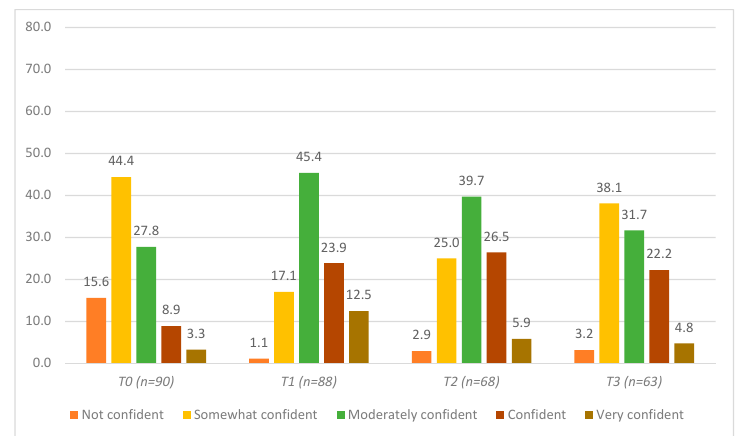
Figure 4. Self-assessment of confidence in helping others with a mental health struggle among agricultural community members in Ontario, Canada at four timepoints: pre-training (T0), post- training (T1), 3 months post-training (T2), and 6 months post-training (T3).